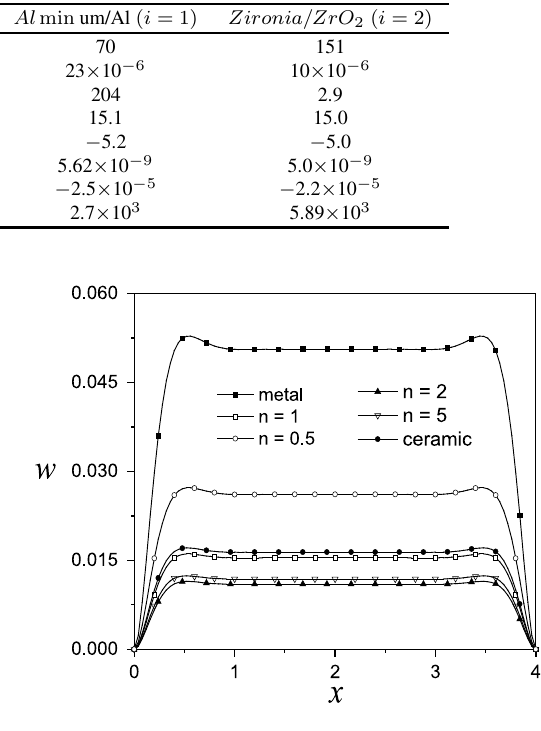
Fig. 5. Deflection of the mid-plane for the clamped supported FGPM cylindrical shell imposed by a thermal load, with different volume fraction index n ( q = 0 MPa, T 1 = 200 , T 2 = 0 , a = 1 m, L = 4 m, a/h = 20 , φ 1 = 0 , φ 2 = 0